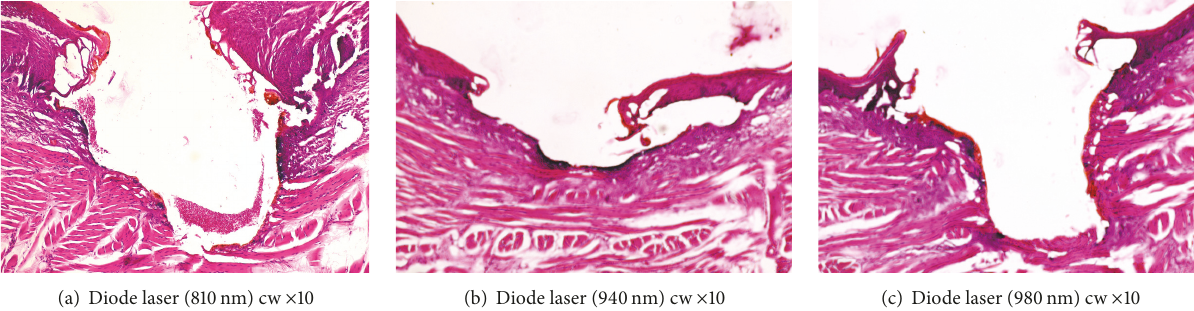
Figure 2: Histological sections (a), (b), and (c) of incisions made with diode lasers (810nm, 940 nm, and 980 nm) cw: carbonization, the presence of dense eosinophilic layers (denatured collagen) and vascular changes (x10, H&E staining).